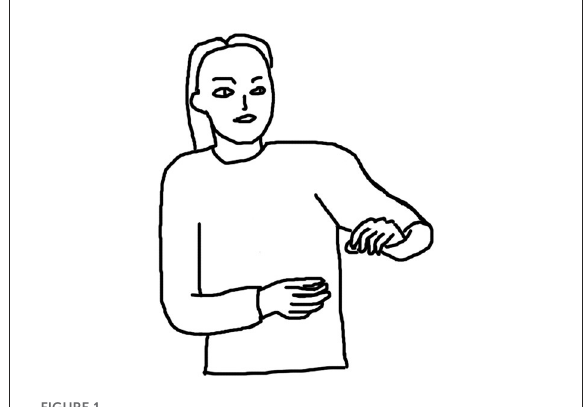
FIGURE1 An example of an iconic gesture.